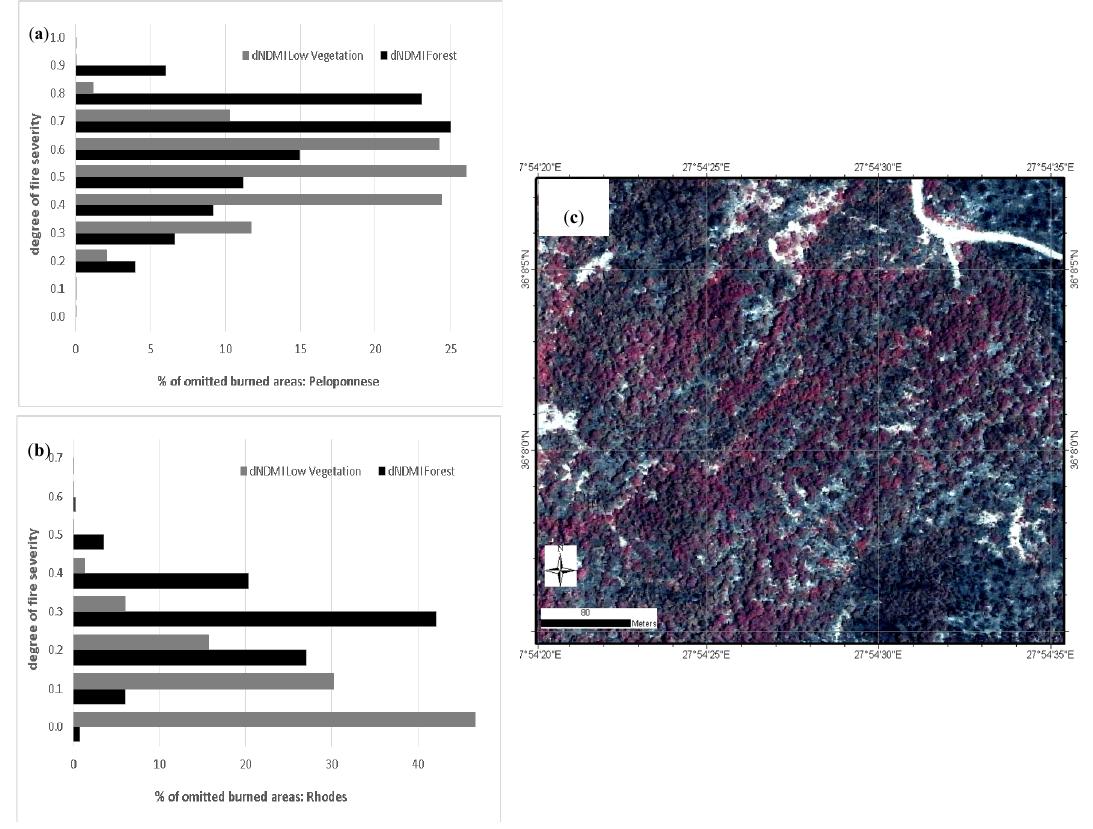
Figure 8. Statistics related to the differenced Normalized Difference Moisture Index (dNDMI) values of the areas omitted by the classification for the study areas of the Peloponnese ( a ) and Rhodes Island ( b ). ( c ) Subset of the IKONOS VHR image (R: Near-infrared (0.757–0.853 µm), G: Red (0.632–0.698 µm), B: Green (0.506–0.595 µm)), depicting the high heterogeneity, in terms of a mixture of burned and unburned trees, of the burned areas omitted by the classification scheme for the study area of Rhodes Island. Red areas represent healthy vegetation whereas burned areas are represented by black and grey